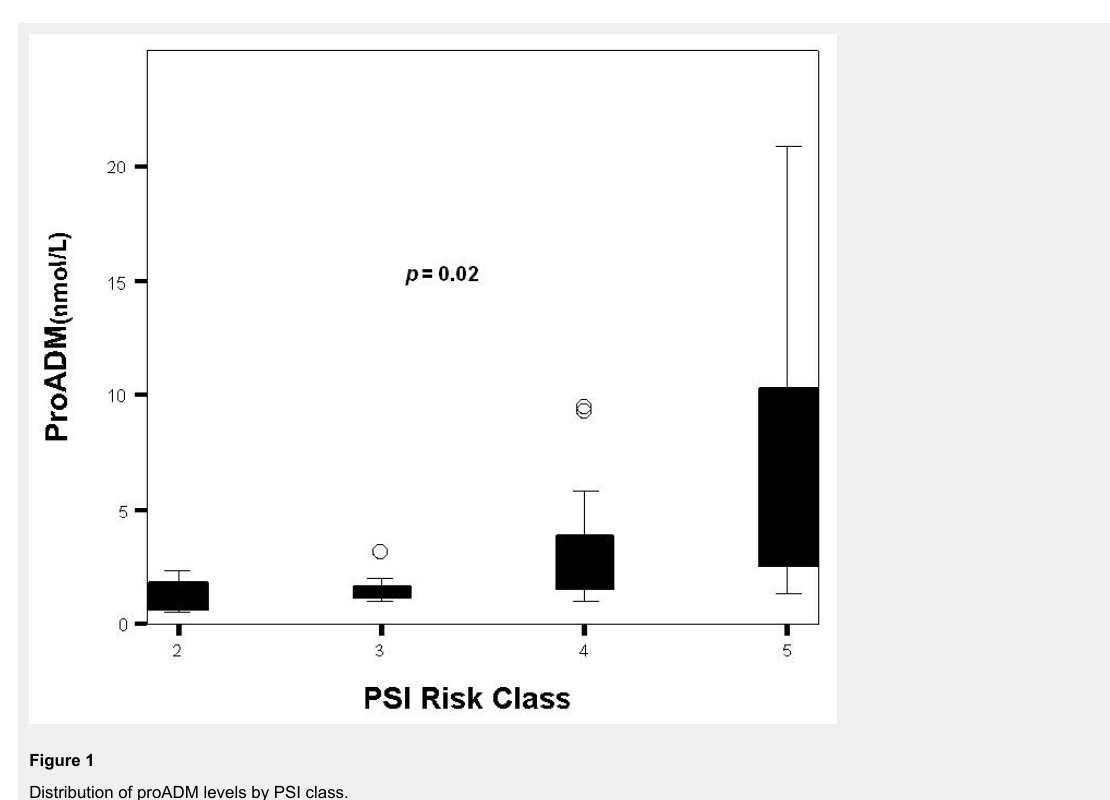
Figure 1 Distribution of proADM levels by PSI class.